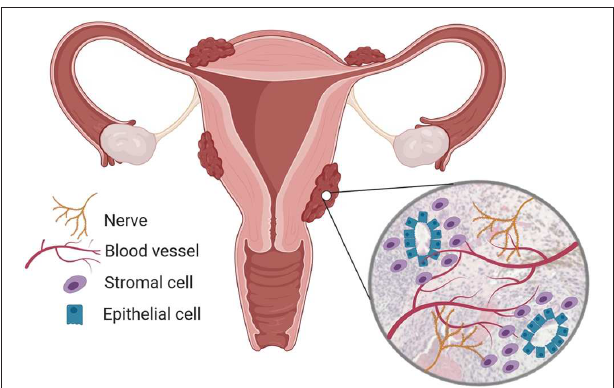
FIGURE 1 | Endometriosis is a chronic inflammatory condition. Endometriosis is characterized by the presence of endometrial-like tissue found outside the uterus, most commonly in the peritoneal cavity. Endometriosis lesions are heterogenous but usually contain endometrial stromal cells and epithelial glands, immune cell infiltrates and are vascularized and innervated by nerves. Created using